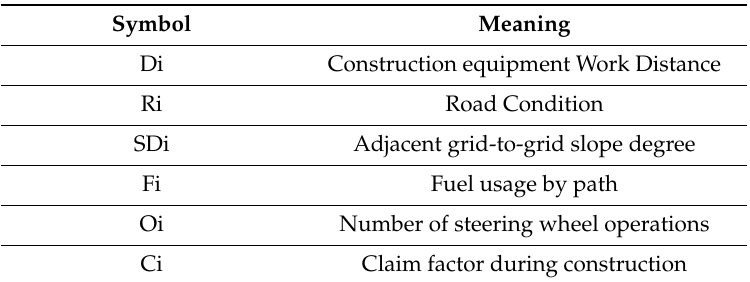
Table 6. List of algorithm symbols.